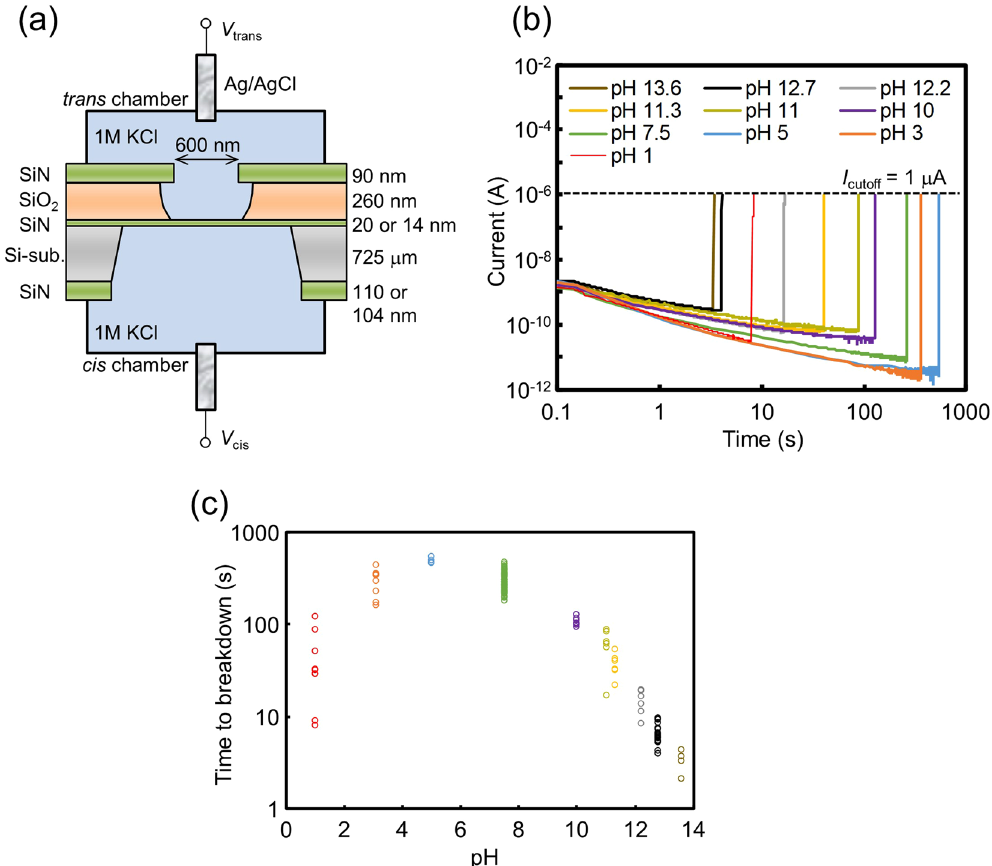
Figure 1. Dielectric breakdown of SiN membranes by CBD under various pH conditions. ( a ) Schematic illustration of the setup for dielectric breakdown experiments. ( b ) Current-time traces during CBD of 20-nm- thick SiN membranes under ten different pH conditions. V cis and V trans were set at 20 V and 0 V during CBD, respectively. ( c ) TBD of 20-nm-thick SiN membranes under the ten different pH conditions. V cis and V trans were set at 20 V and 0 V during CBD, respectively. The number of plots at each pH is at least